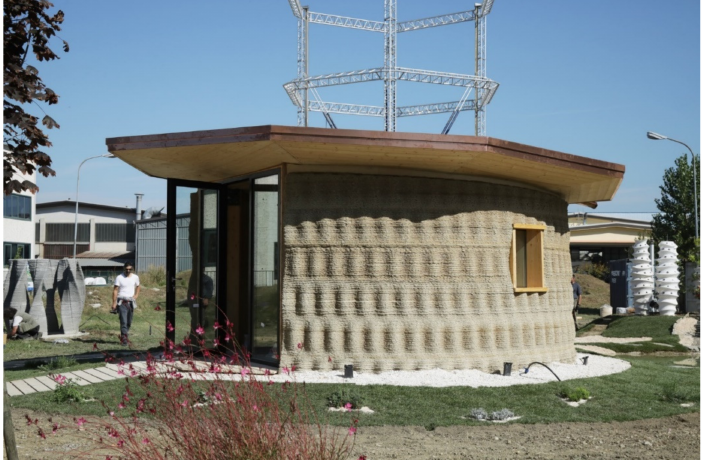
Figure 11. WASP 3D-printed Gaia project [10]. Reprinted with permission from Ref. [10]. 2018,